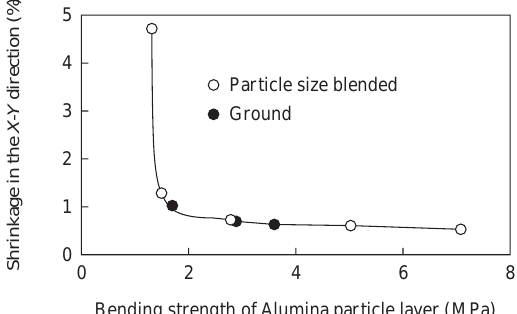
Fig. 13 Shrinkage in the X-Y direction as a function of bending strength of alumina particle layer for particle size blended and ground